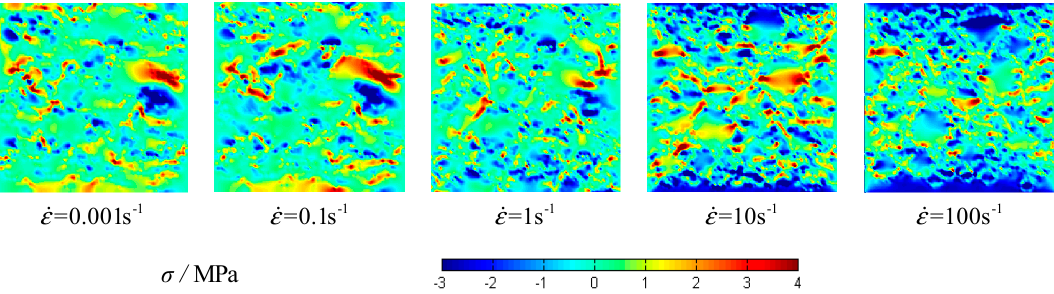
Figure 13. The distribution of maximum principal stress at different strain rates of specimen 1.